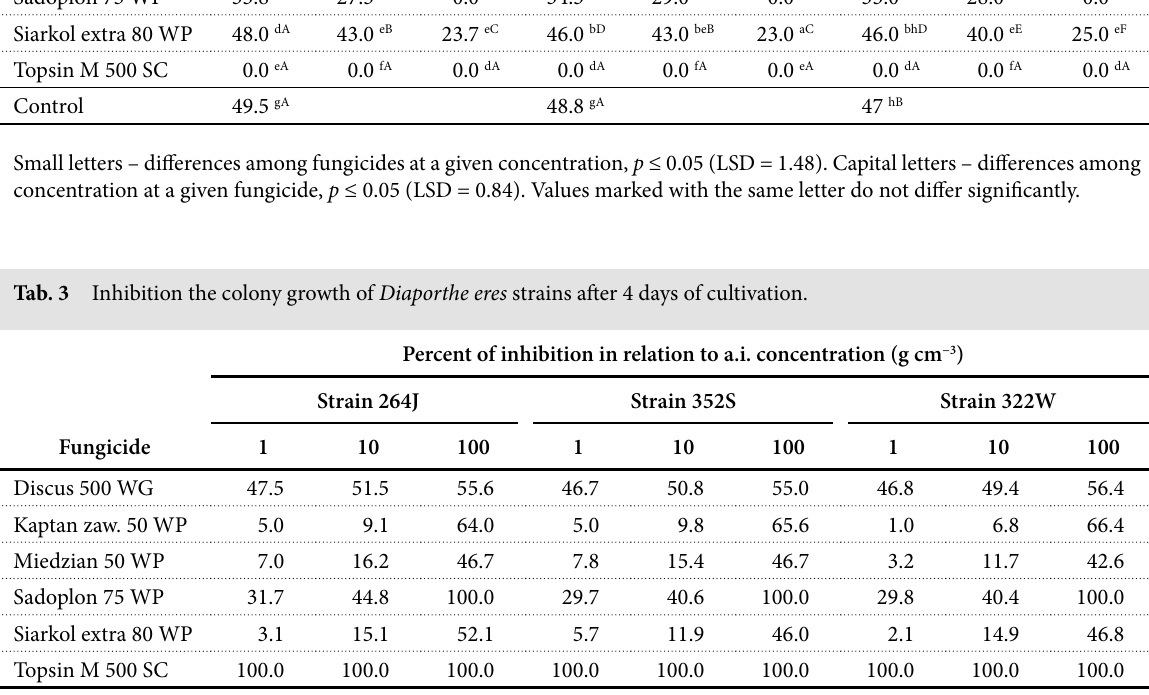
Tab. 4 Effect of fungicides on mycelial growth of Diaporthe eres strains after 8 days of cultivation.